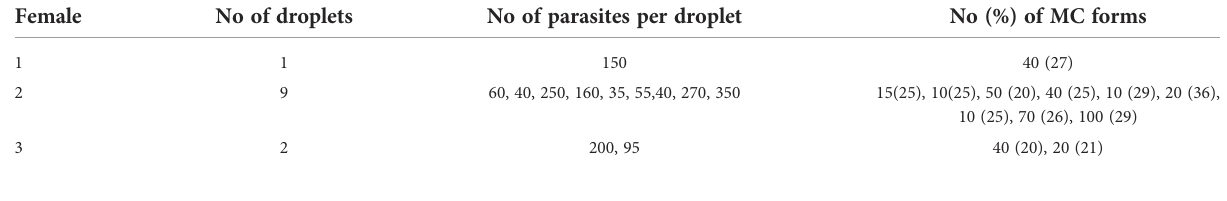
TABLE 2 Numbers of Porcisia deanei in urine droplets of Lutzomyia longipalpis